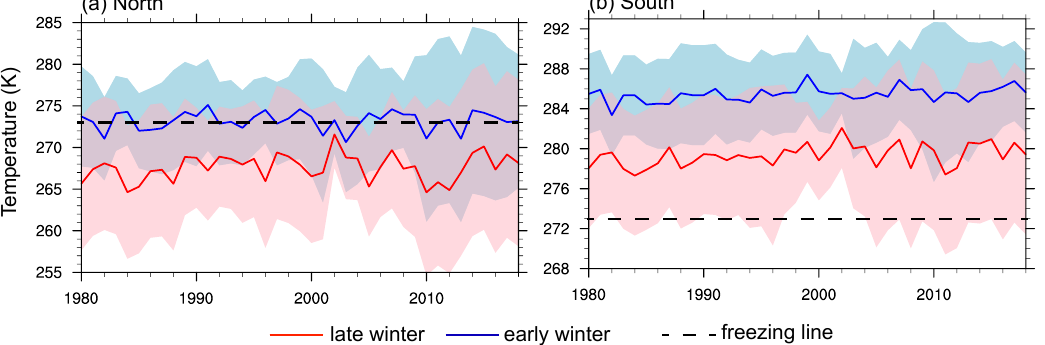
Figure 2. Time series of the areal mean temperatures in ( a ) the northern and ( b ) the southern parts of East China: The solid lines are the sub-seasonal mean temperatures, the shaded areas represent one standard deviation for the given sub-season (blue for early winter and pink for late winter; the gray color is the overlap of early and late winter), and the dashed lines represent 273.15